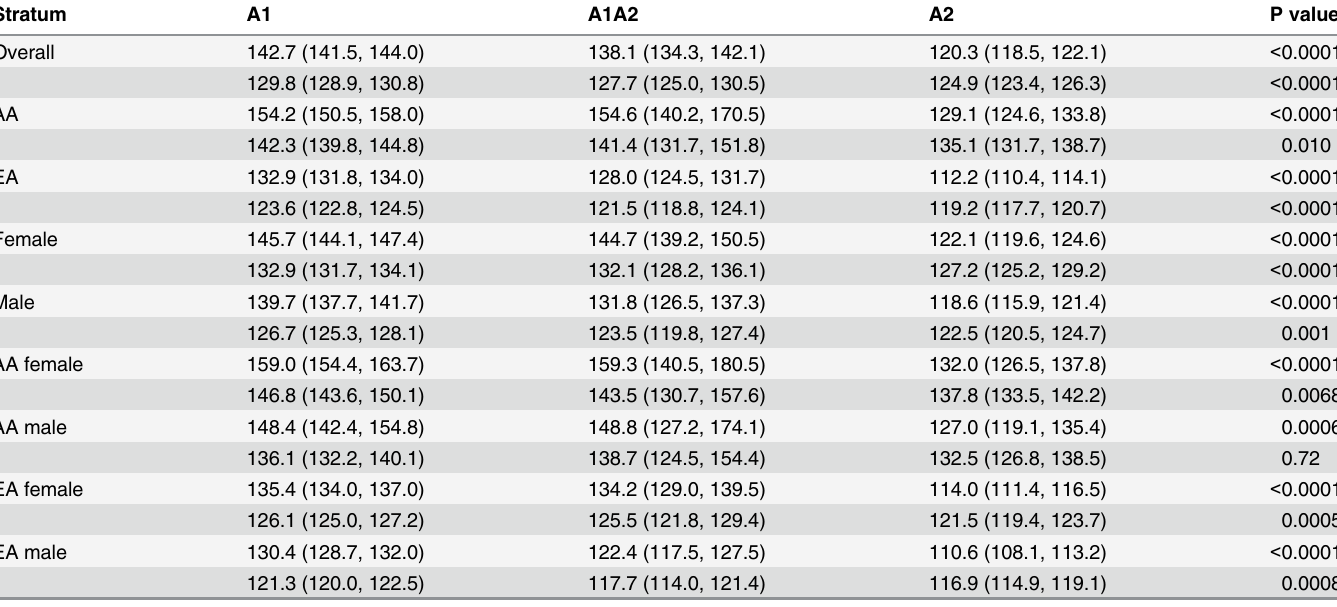
* Top row: values adjusted for age, smoking, BMI, diabetes, and hypertension and bottom row (shaded): values adjusted for environmental factors as in top row, but also for